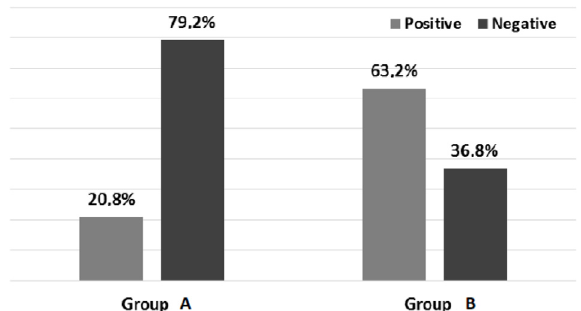
Figure 6. Stair-climbing test after surgery. Group A (<2.5 cm) vs. group B (>2.5 cm). ( p <